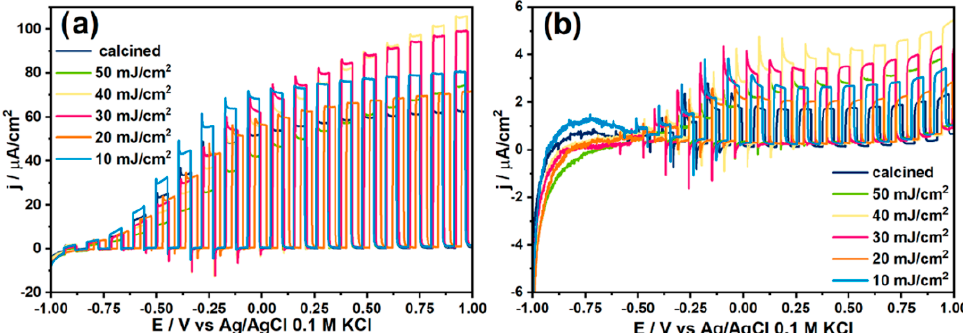
Figure 5. Linear voltamperograms of laser-modified anatase TNTs in comparison to a calcined sample carried out in 0.5 M of Na 2 SO 4 electrolyte in UV-vis ( a ) and vis ( b ) light. Reprinted with permission from [53].